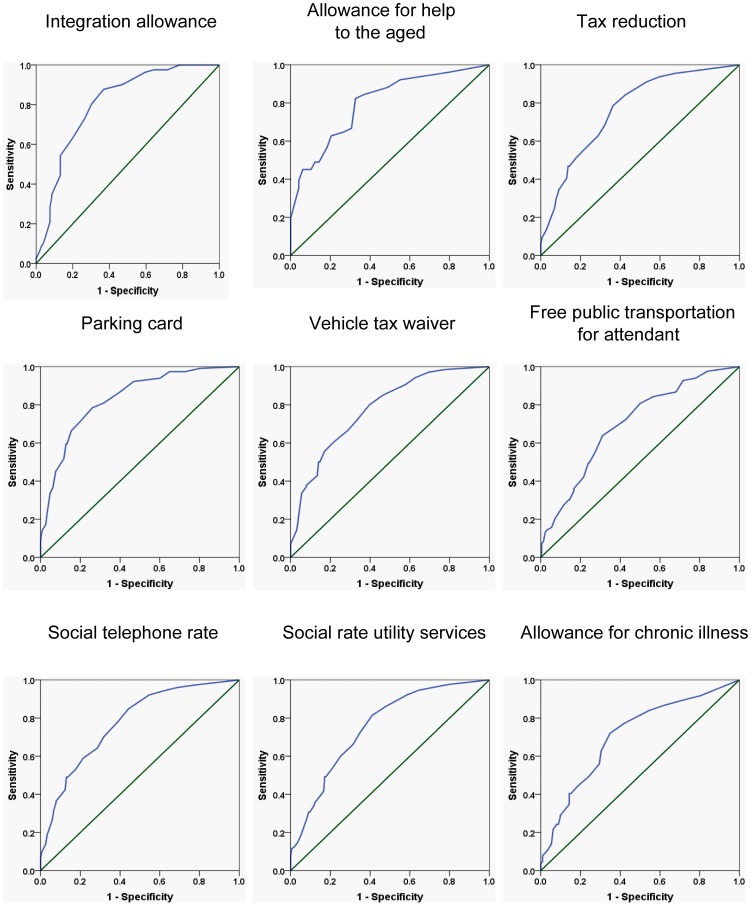
ROC curves for HAQ predicting the need for different social support measures.Receiver operator characteristic analysis (ROC) demonstrates that the Health Assessment Questionnaire (HAQ) performs well as a tool to predict the need for social support measures in patients with RA. The recommendation by the treating rheumatologist was used as reference.